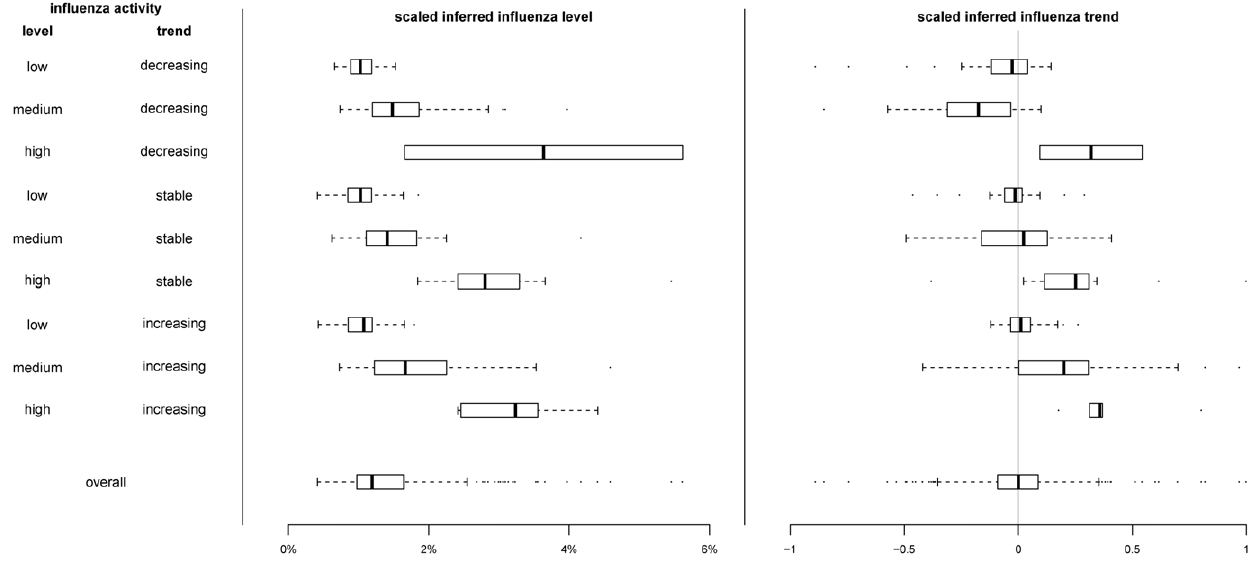
Figure 3. Box-plot of inferred influenza level and trend based on multivariate dynamic linear model utilizing four surveillance data streams including influenza-like illness consultation rates in public General Outpatient Clinics (GOPC) and private general practitioners (GP), school absenteeism rates, and number of consultations with patients with febrile illness in Designated Flu Clinics, under different patterns of influenza activity. Influenza activity was defined as low, medium or high if it is lower than 0.4%, between 0.4–2.5%, or higher than 2.5% respectively, defined as decreasing, stable or increasing if the percentage change between the following and preceding week is lower than 2 40%, between 2 40–40% or higher than 40% respectively. The inferred influenza level was scaled to the range of the influenza activity proxy measure (product of laboratory influenza isolation rate and GP ILI rate), while the inferred trend of influenza activity under the same model was scaled to the range [ 2 1, 1].